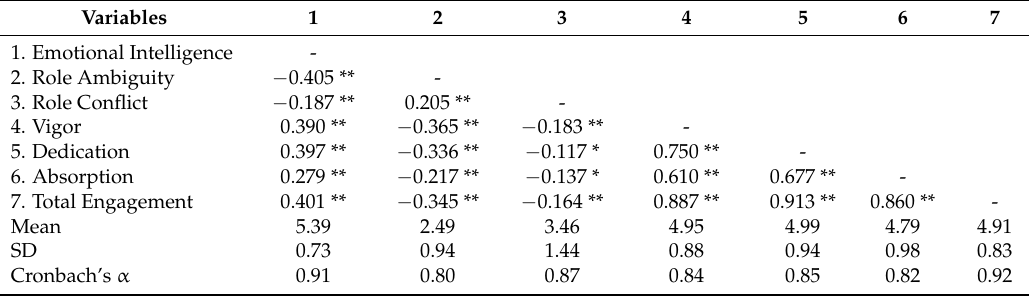
Table 1. The means, standard deviations, reliabilities, and correlations between study variables.